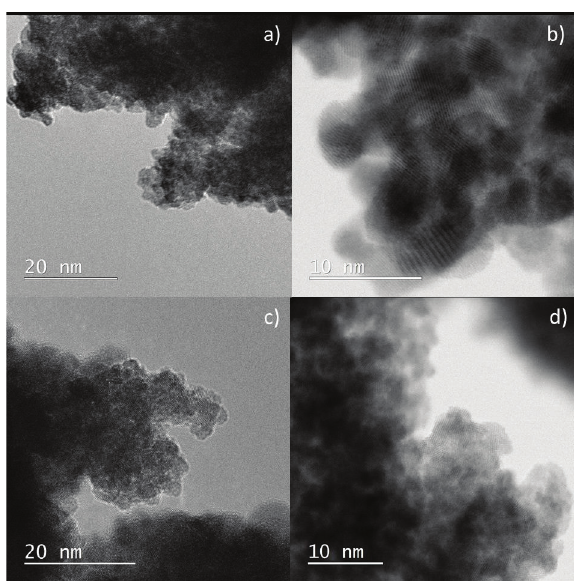
Fig. 1 – STEM-BF micrographs of the pure (a and b), and doped (c and d) samples